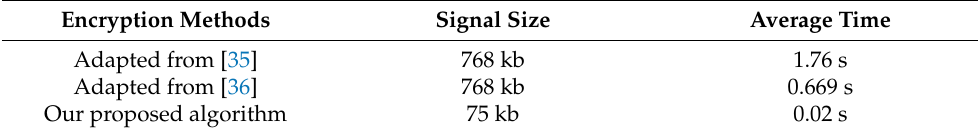
Table 3. The comparison results with encryption